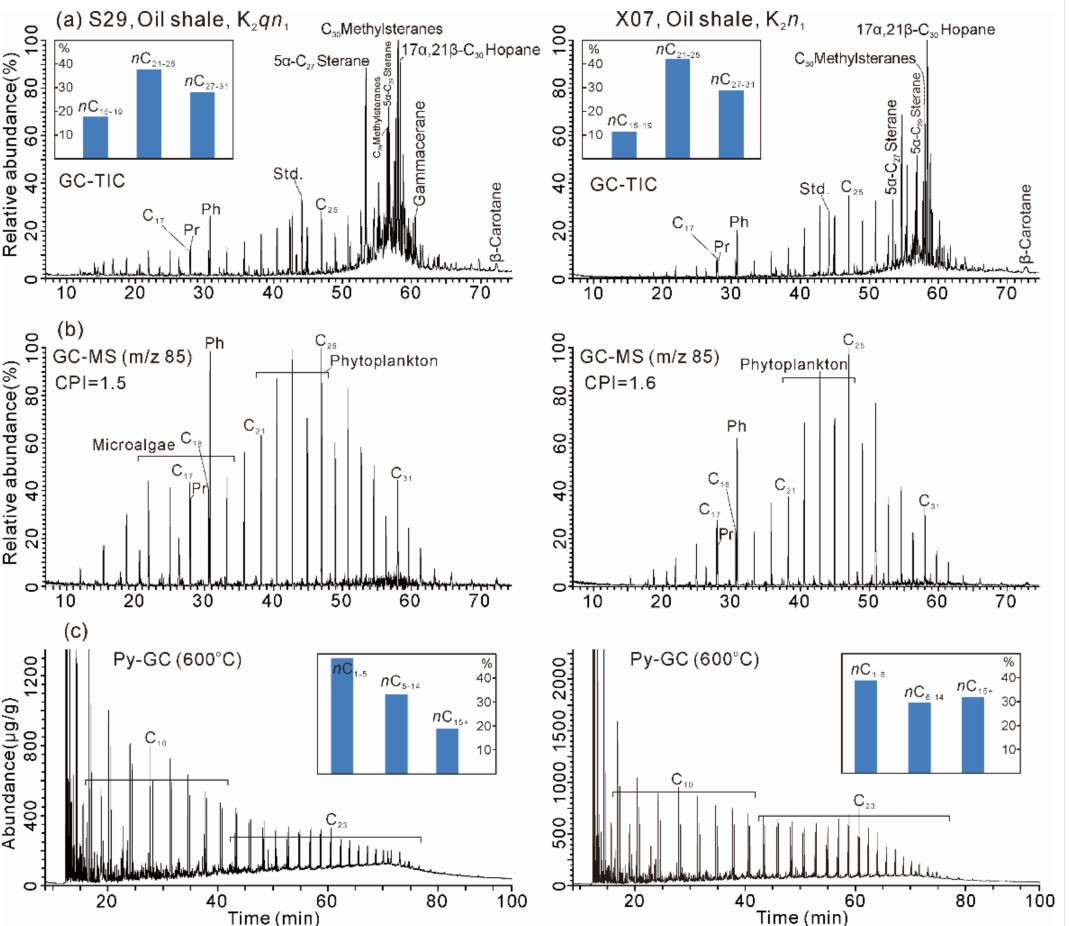
Figure 9. n -alkane distributions and their contents from gas chromatograms (TIC) ( a ), gas chromatograms-mass chro- matograms (GC-MS) (m/z 85) ( b ), pyrolysis-gas chromatography (Py-GC) ( c ) of saturated hydrocarbon fractions for oil shale samples S29 from the K 2 qn 1 , and X07 from the K 2 n 1